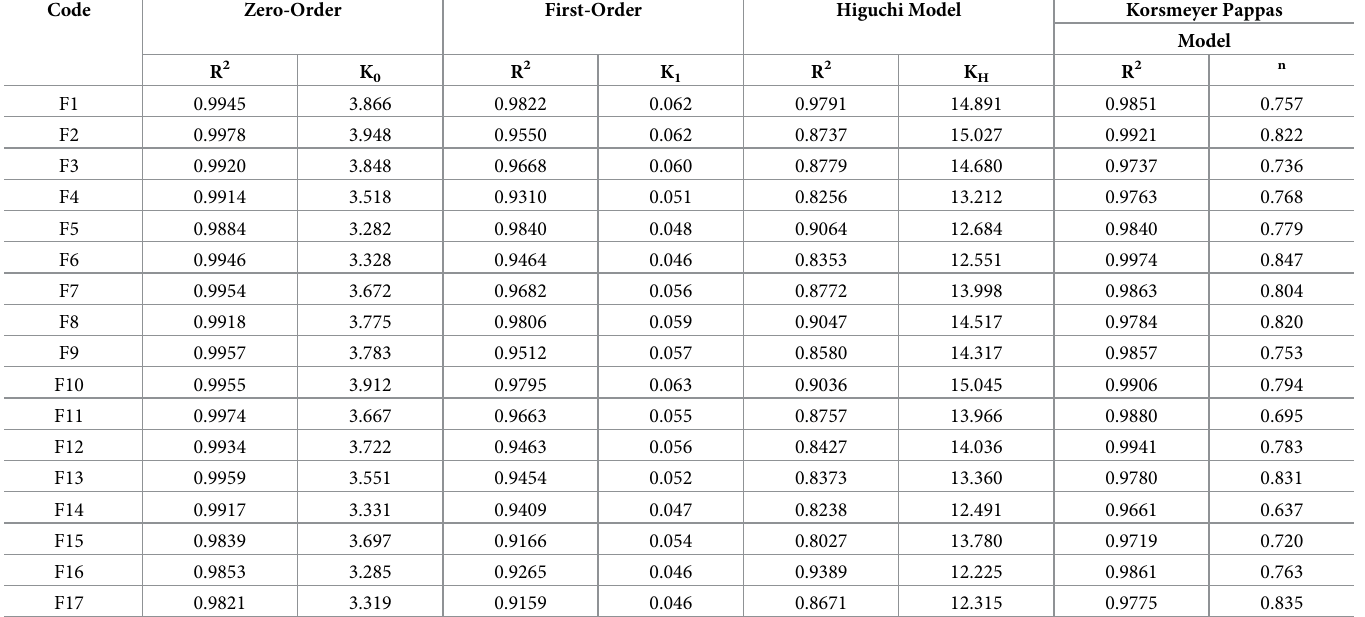
Table 4. Kinetic modeling figures of in vitro drug